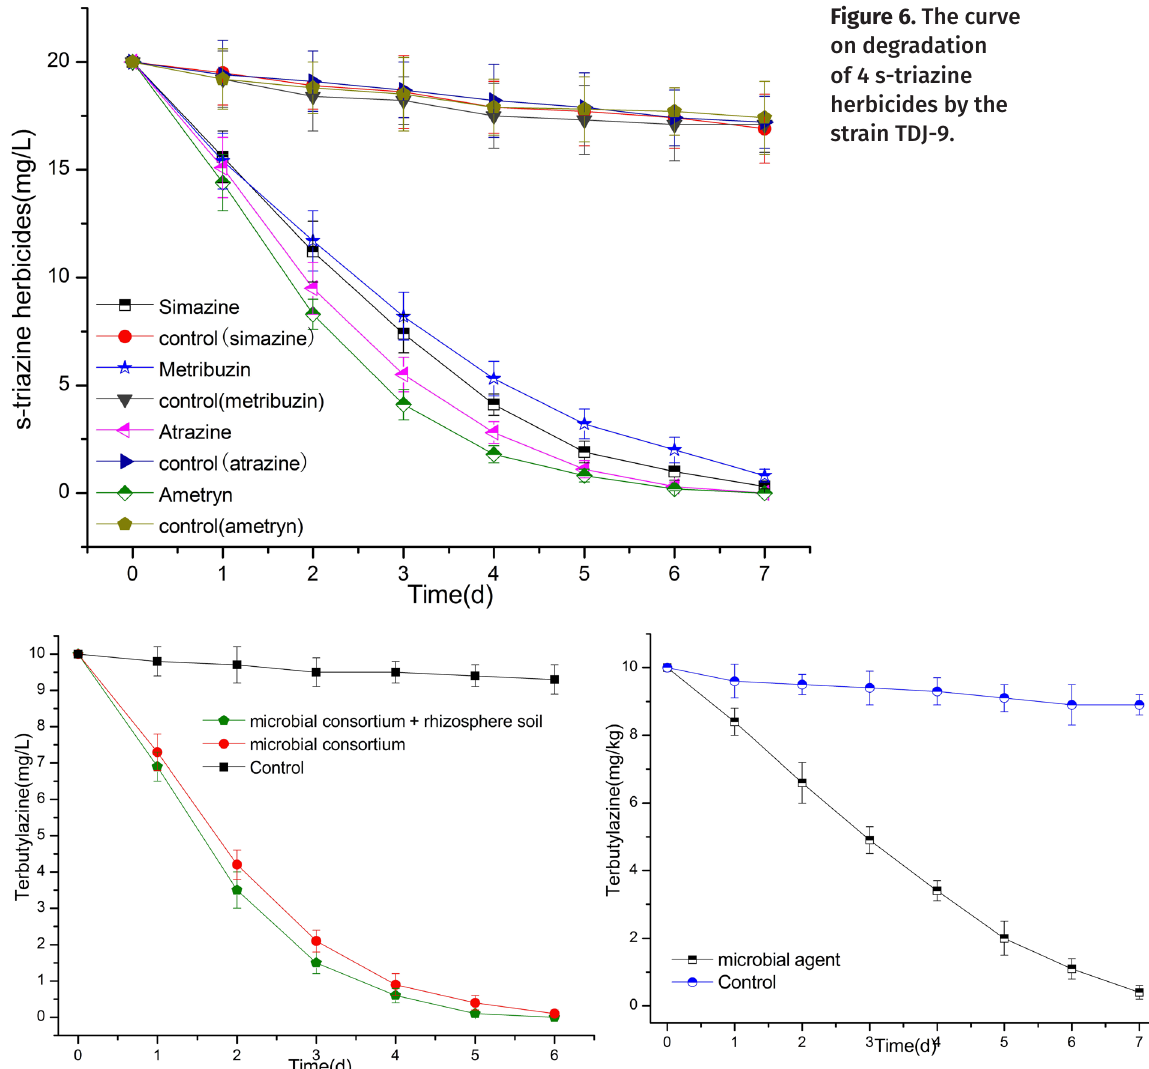
Figure 7. Degradation of terbutylazine by microbial consortium and rhizosphere soil. terbutylazine in soil by microbial ①